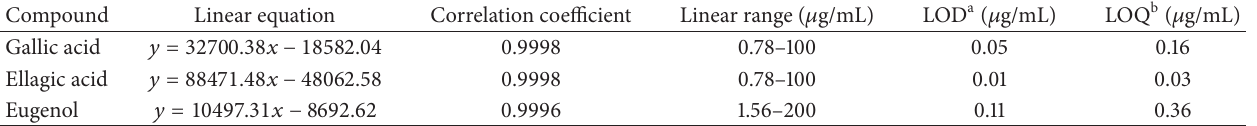
Table 1: Linear regression, correlation coefficients ( 𝑟 2 ), LOD, and LOQ for the reference compounds (𝑛 = 3) . Compound